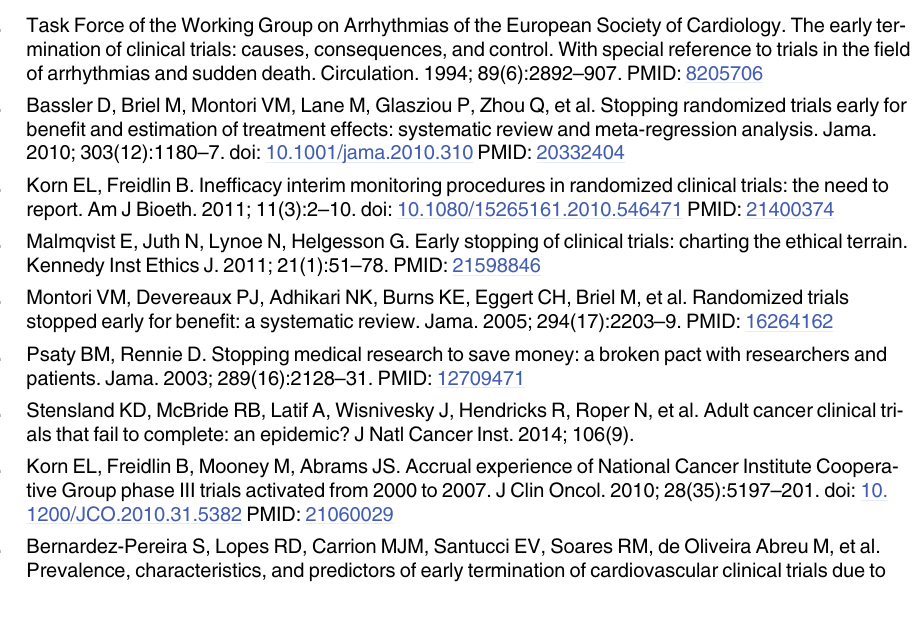
S1 Table. Characteristics of terminated trials in the ClinicalTrials.gov results database. S2 Table. Disease/Condition categories of terminated trials in the ClinicalTrials.gov results